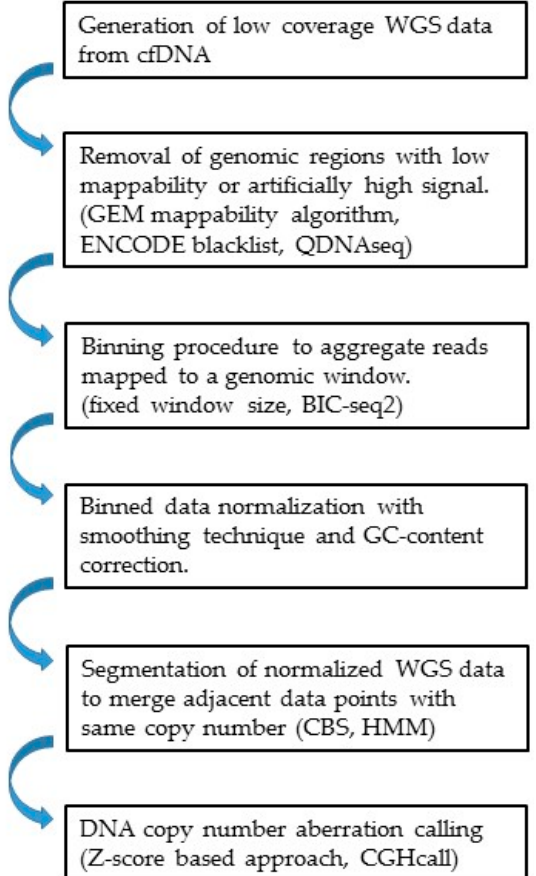
Figure 3. Bioinformatics procedure and techniques/resources used to detect copy number variations (CNVs) from low coverage whole genome sequencing (WGS) data.